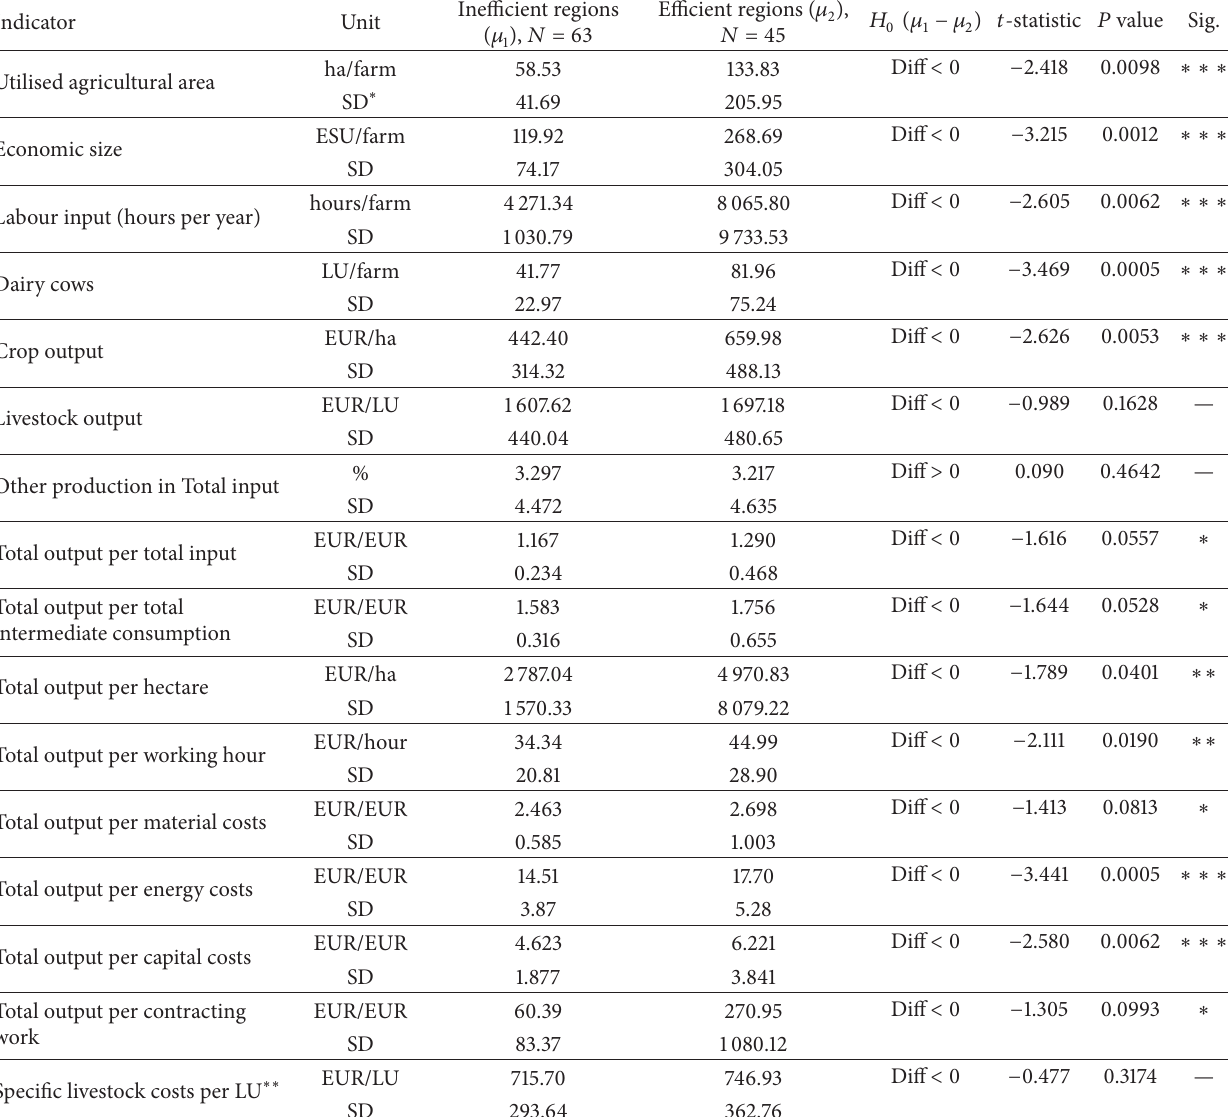
Table 4: Differences in economic indicators.